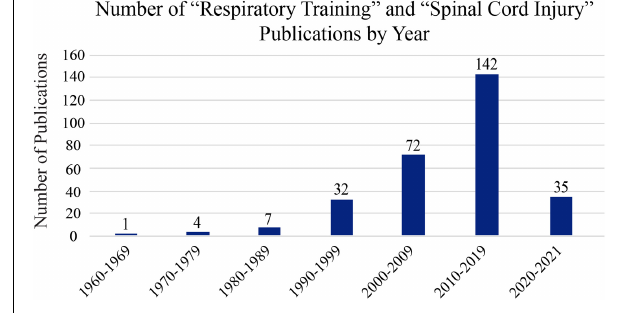
FIGURE 3 | Publication history of respiratory training post-SCI. A PubMed search was made using the terms “respiratory training” and “spinal cord injury” to assess the relative number of research papers on this topic over the last 60 years. As the image shows, interest on this topic is increasing exponentially with each